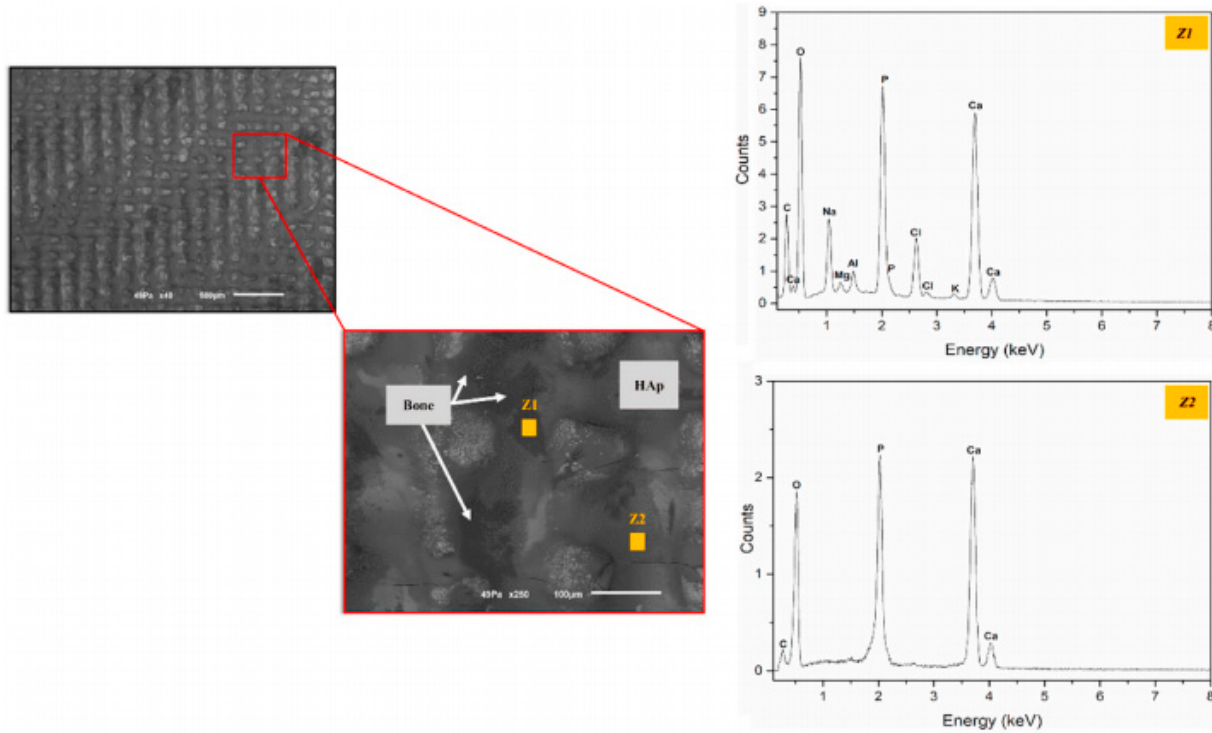
Figure 5. SEM images of HAp-coated zirconia textured surface, after the friction tests against bone and the subsequent EDS spectra of evident zones, Z1 and Z2 [70]. Reprinted from [70]. Copyright from Elsevier 2020.